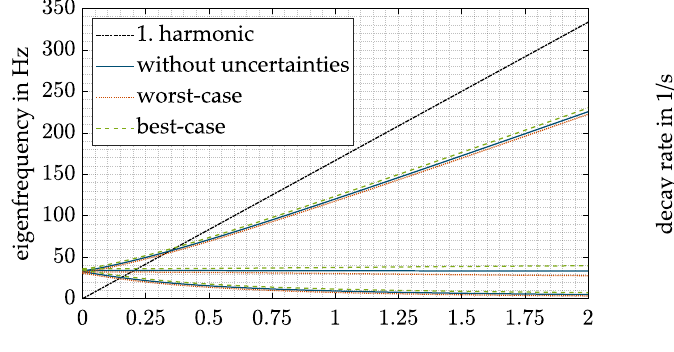
Figure 9. ( a ) Campbell diagram with DVFC; ( b ) decay rate with DVFC. Figure 10. DVFC for the best- and worst-case combinations of all uncertainties: ( a ) Campbell diagram; ( b ) decay rate.